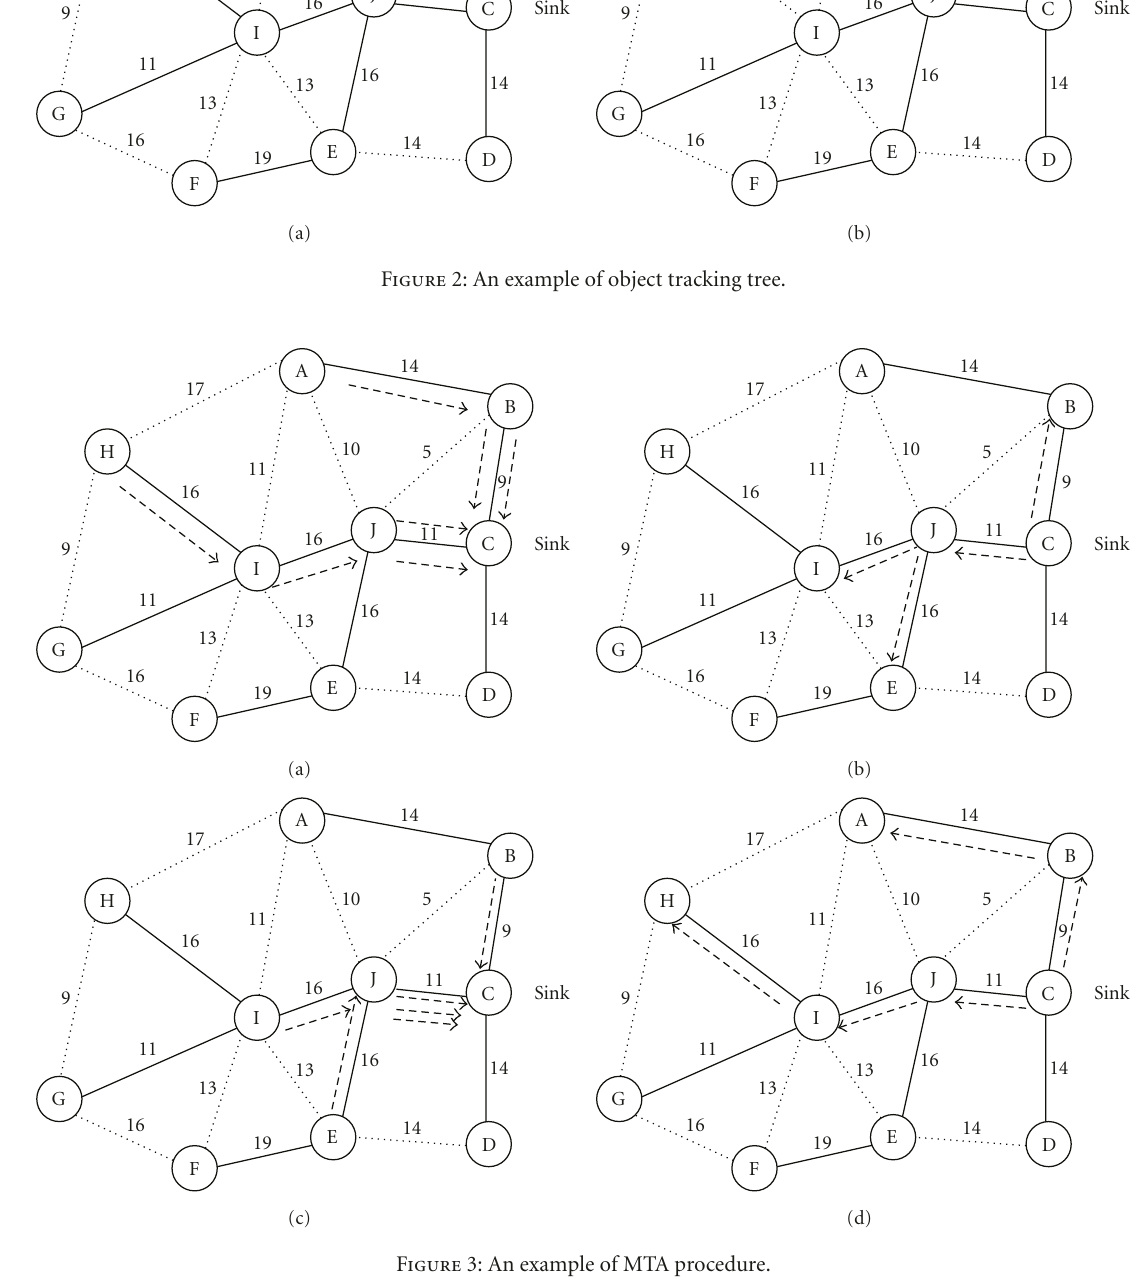
Figure 3: An example of MTA